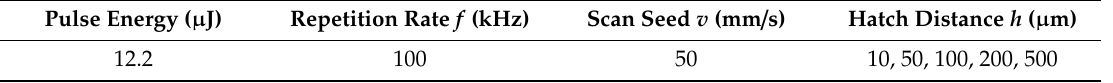
Table 1. Process parameters for the microstructuring of the Al2024 via laser ablation.